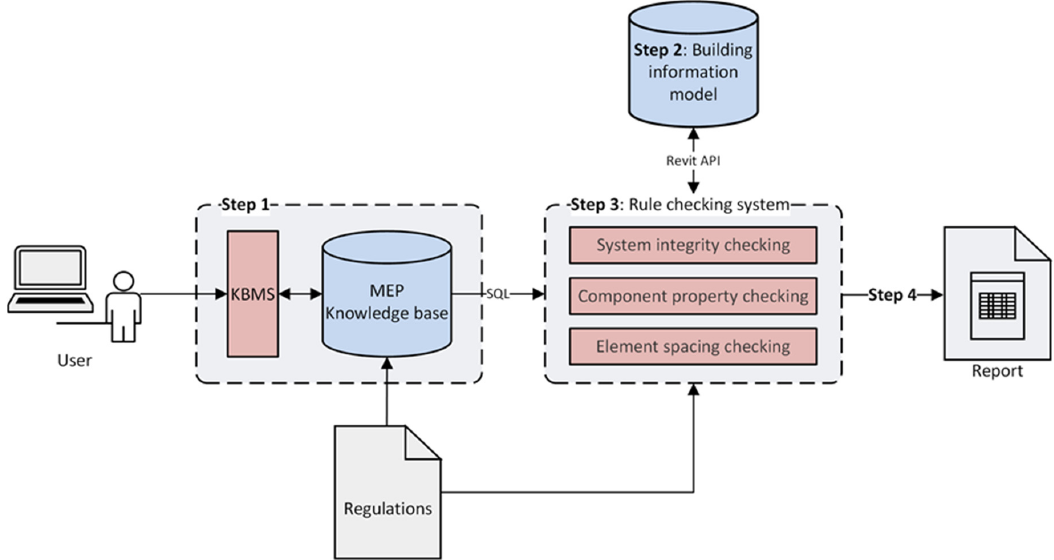
Figure 1. Framework of this study.